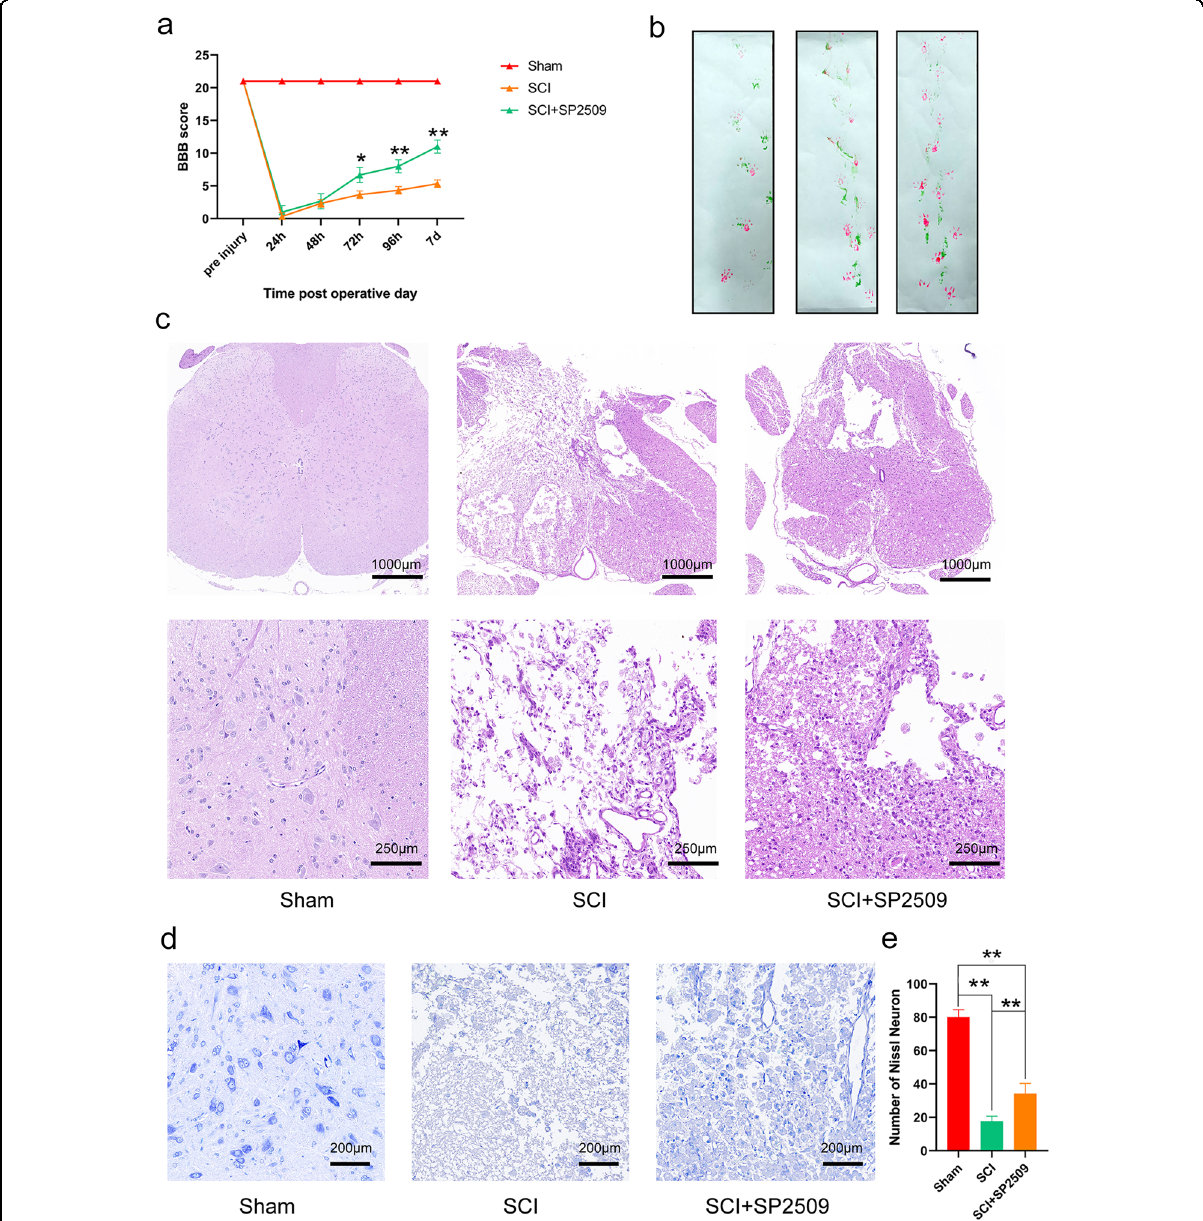
Fig. 1 Pharmacologically inhibiting LSD1 based on SP2509 enhanced function recovery and protected spinal cord tissue. a BBB scores at various times following spinal cord contusions. b Example footprints of rats walking 1 week following SCI. Red: paw print — front paw; green: paw print — hind paw. c Representative H&E stained transverse sections. Scale bar = 1000 μ m. d , e Nissl staining for testing survival neurons to